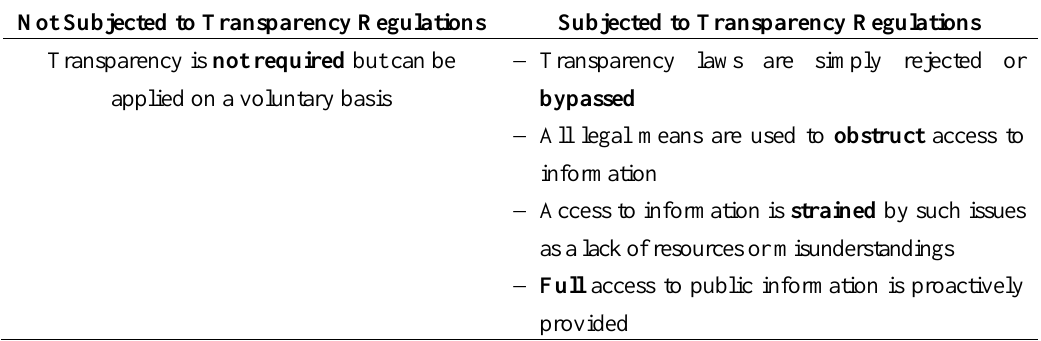
Table 2. Types of restrictions to